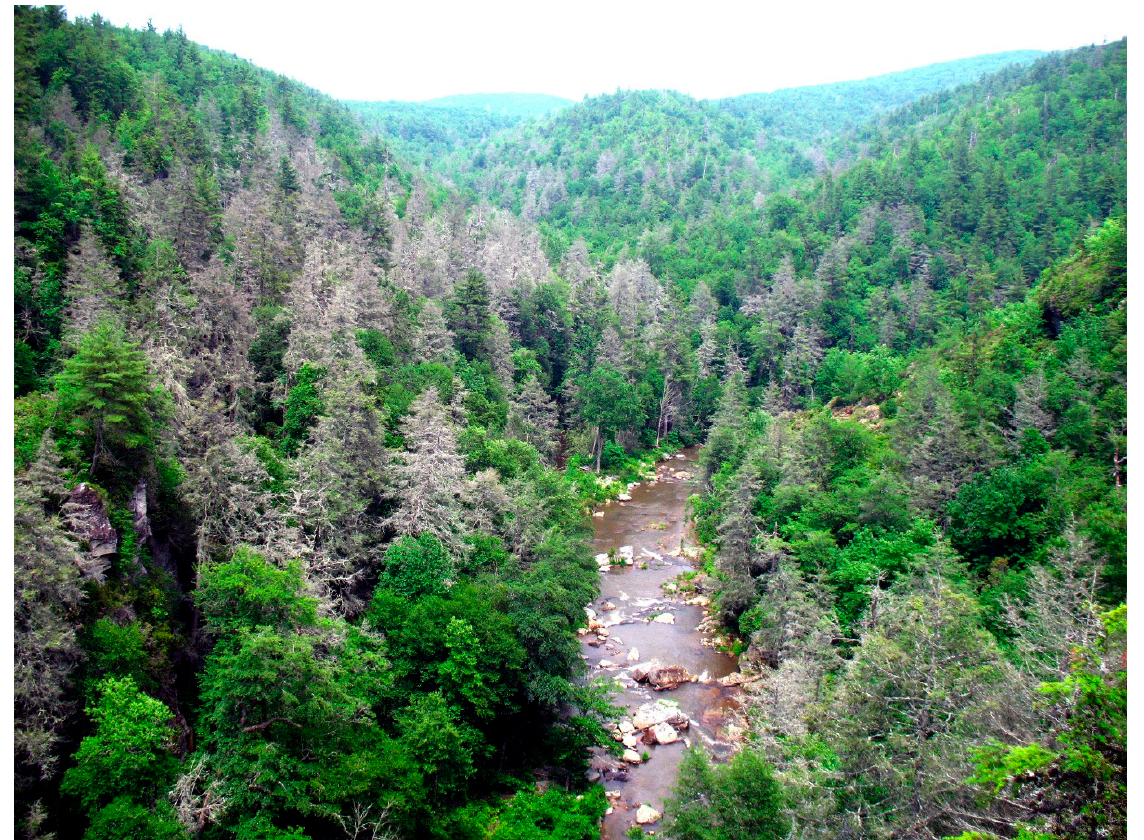
Figure 1. An example of impacts of a forest pest: infested hemlock trees by a hemlock woolly adelgid ( Adelges tsugae ) that killed many trees in the Linville Gorge area of the Great Smoky Mountains, North Carolina (Pisgah National Forest) (Photo by Steve Norman, USDA Forest Service). From https://forestthreats.org/products/photos-and-videos/photos/hemlock-woolly-adelgid/image (accessed on 1 February 2023).